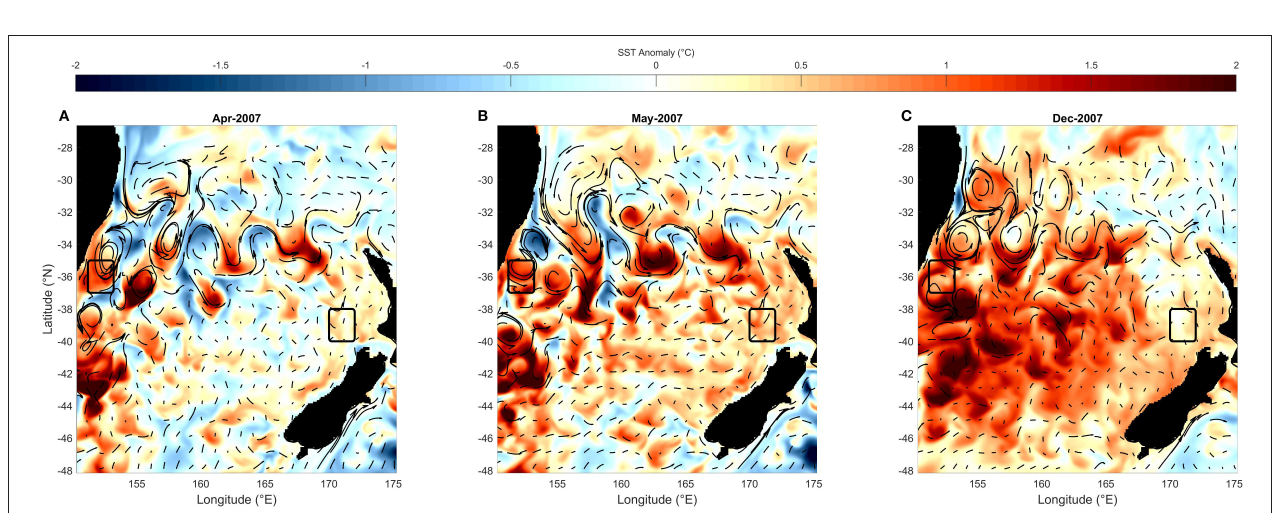
FIGURE 5 | Surface plots of monthly mean surface temperature anomaly during the months when MHWs occurred (in the Eddy box) in 2007: (A) April, (B) May, and (C) December. Surface temperature anomaly is shown with the colourbar and surface currents are shown with vectors.